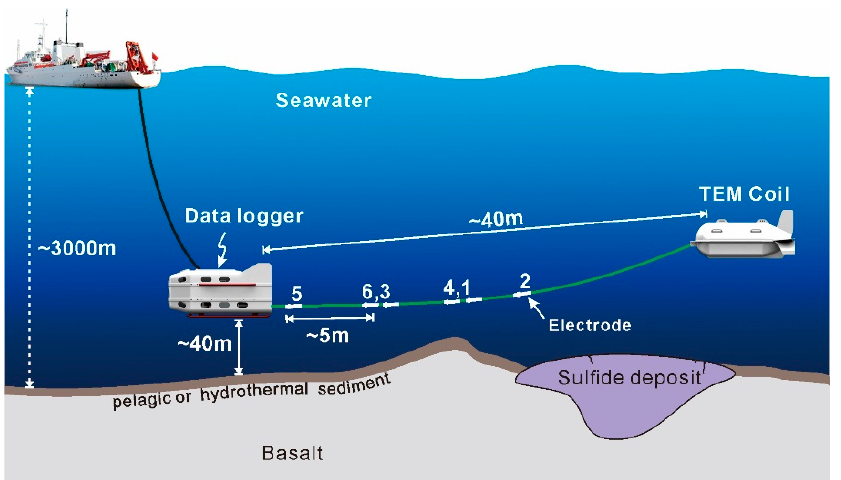
Figure 35. Sketch of the deep-towed geophysical instrument that can also be used to measure the self-potential and possibly the resistivity and the induced polarization. The green line denotes the cable-link-control terminal and the time-domain electromagnetic (TEM) coil. The numbers on the cable show the location of 6 Ag/AgCl nonpolarizing electrodes. The data logger is mounted inside of the control terminal (modified from [115]).